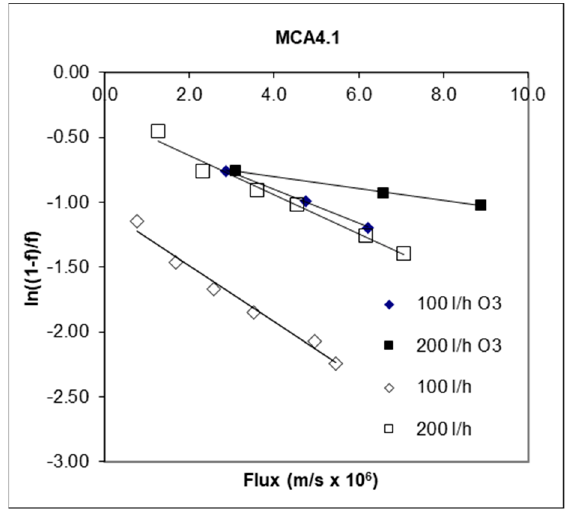
Figure 2. Representation of ln((1 − f )/ f vs. the permeate fluxes in pretreated and non-pretreated effluents for feed flowrates of 100 and 200 L/h.